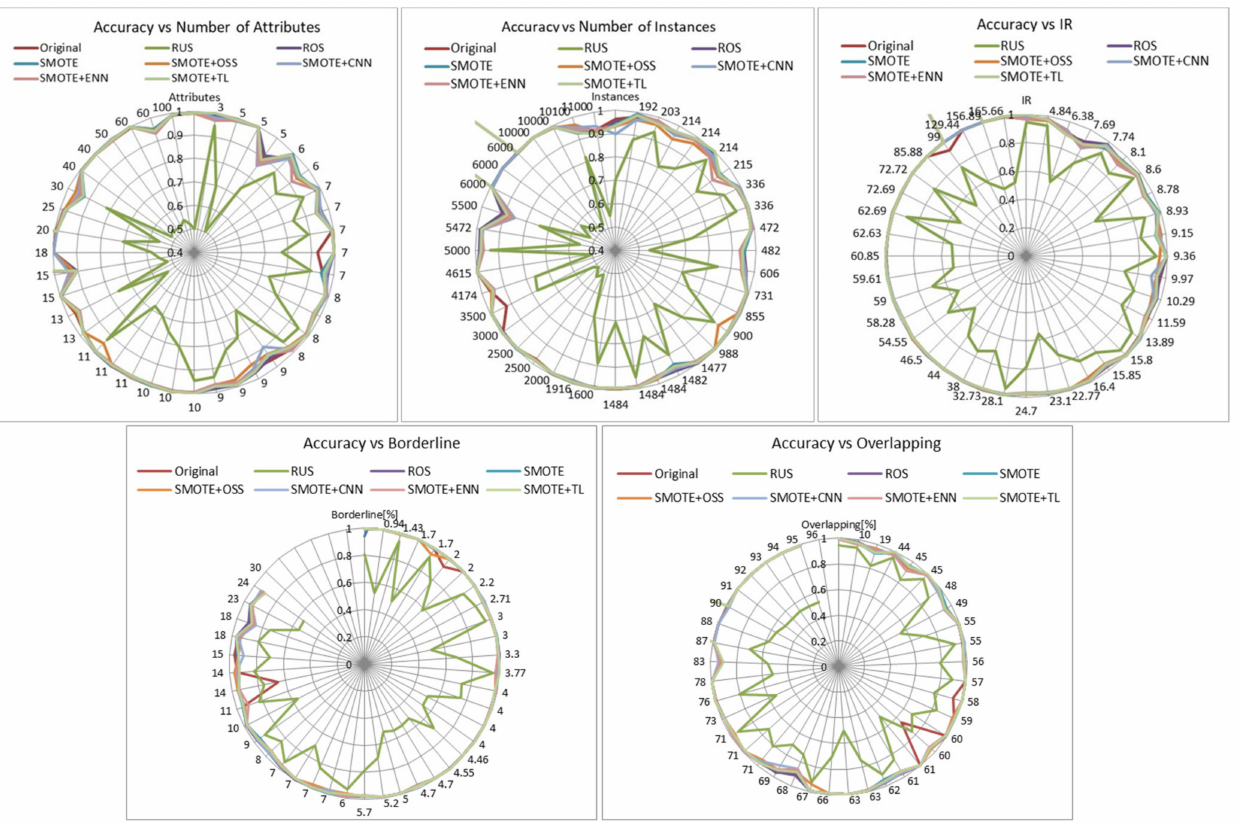
Figure 1. Influence of dataset characteristics on accuracy for all resampling